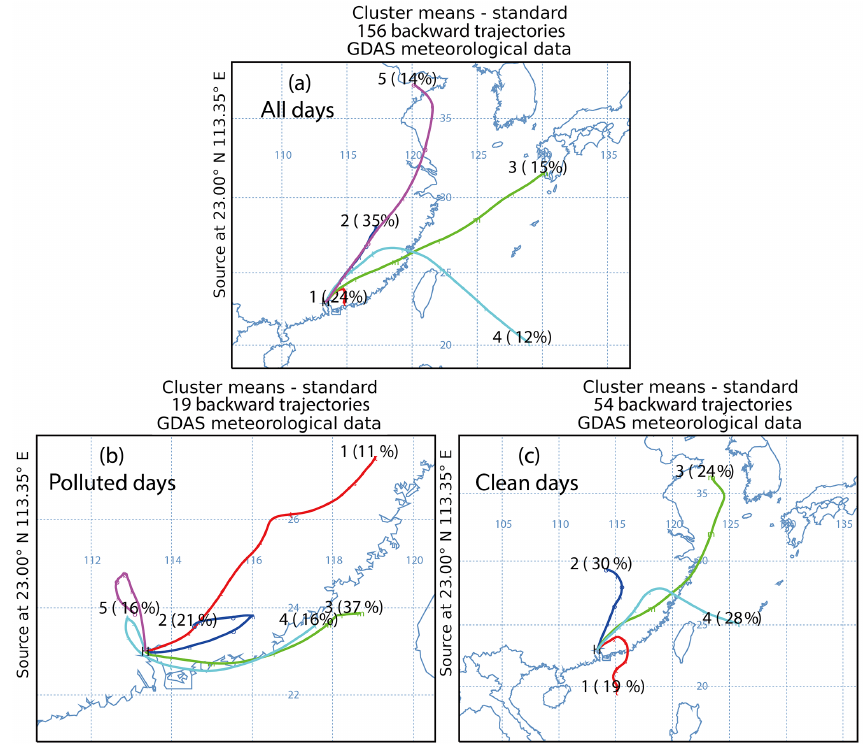
Figure 6. The major clusters for the 72h backward trajectory simulation for air masses arriving at the CAWNET Panyu site with an arrival height of 700m. (a) shows the results throughout the whole observational period, while (b) shows the one during polluted days and (c) is for clean days. All trajectories that are near each other were merged to a mean trajectory to represent the entire groups by cluster analysis. The percentage number beside the labeled cluster indicates how many back trajectories can be represented by this